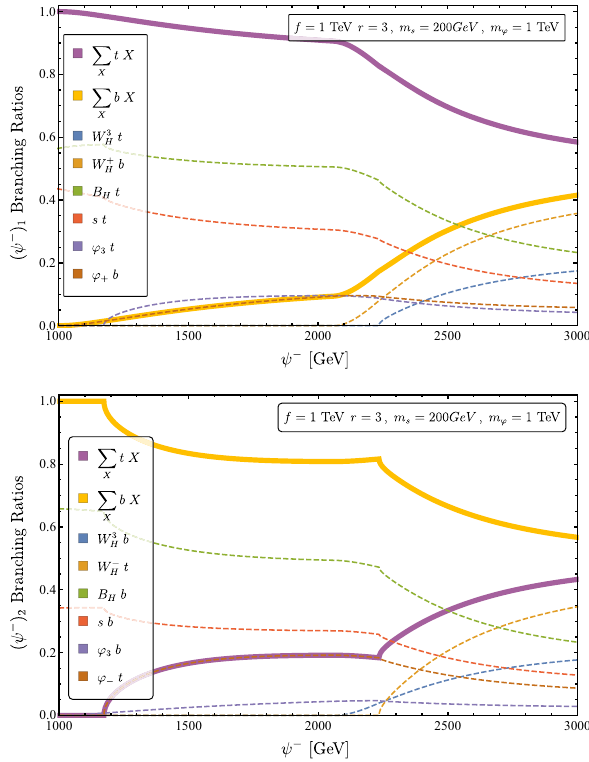
Fig. 2 Numeric results for the branching ratios of the upper (lower) component of ψ − presented in the left (right) panel, with f = 1 TeV , r = 3 , m s = 200 GeV , m ϕ = 1 TeV and λ 2 = 2 . 5. The masses of the heavy gauge boson are fixed at m B = 2 . 1 TeV. The dashed colored lines indicate the branching ratios m W H to the different exclusive final states. The solid thick lines indicate the sum of branching ratios with either a top (purple curve) or a bottom (yellow curve) at the final